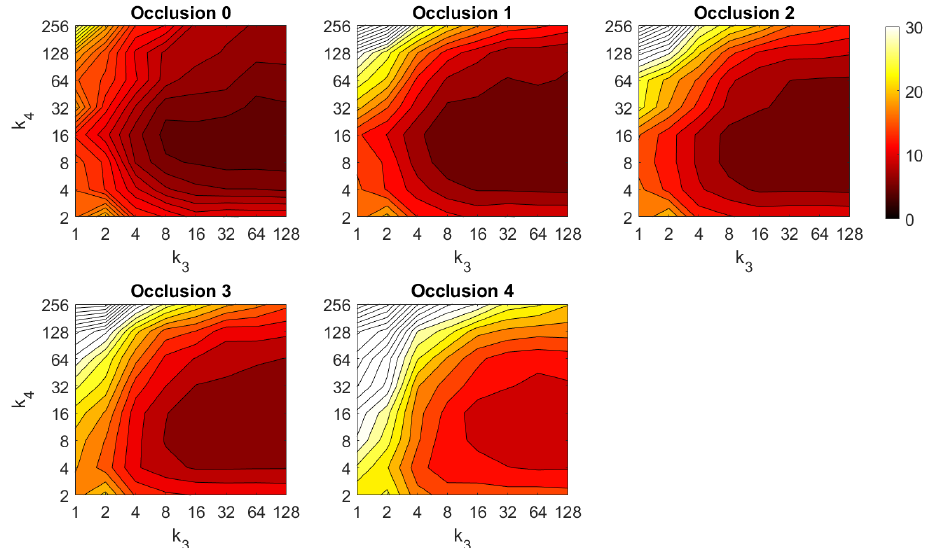
Figure 31. FS orientation estimation in the presence of occlusions. Average orientation error (deg).